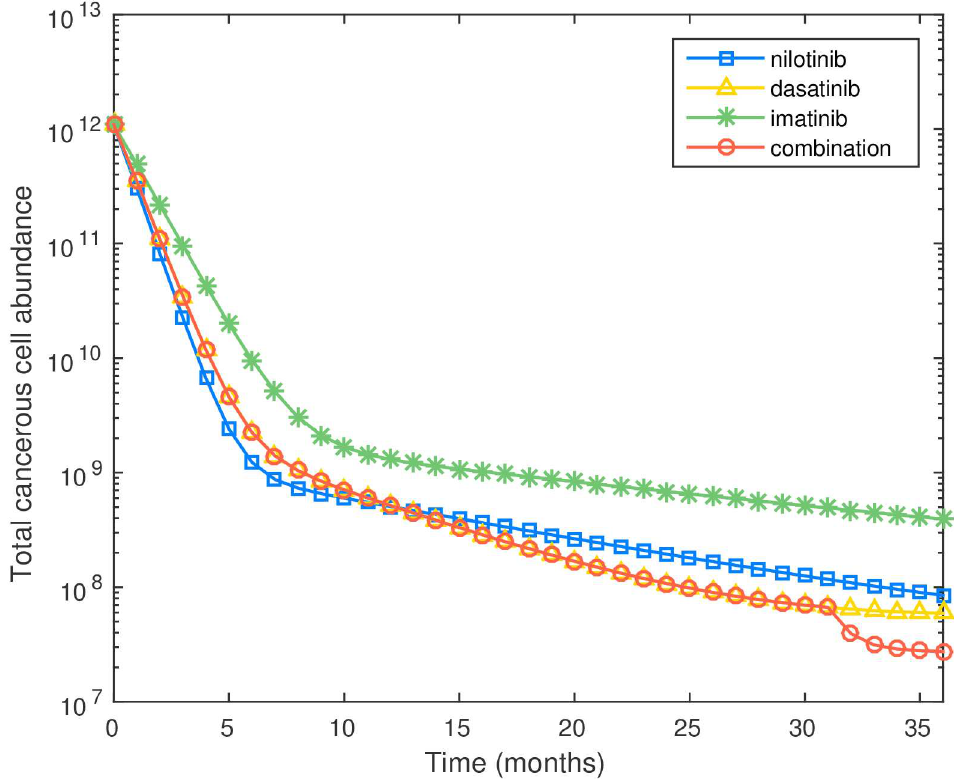
Fig 4. Plot of cell number versus time for three monotherapies and optimal combination therapy for preexisting M351T.